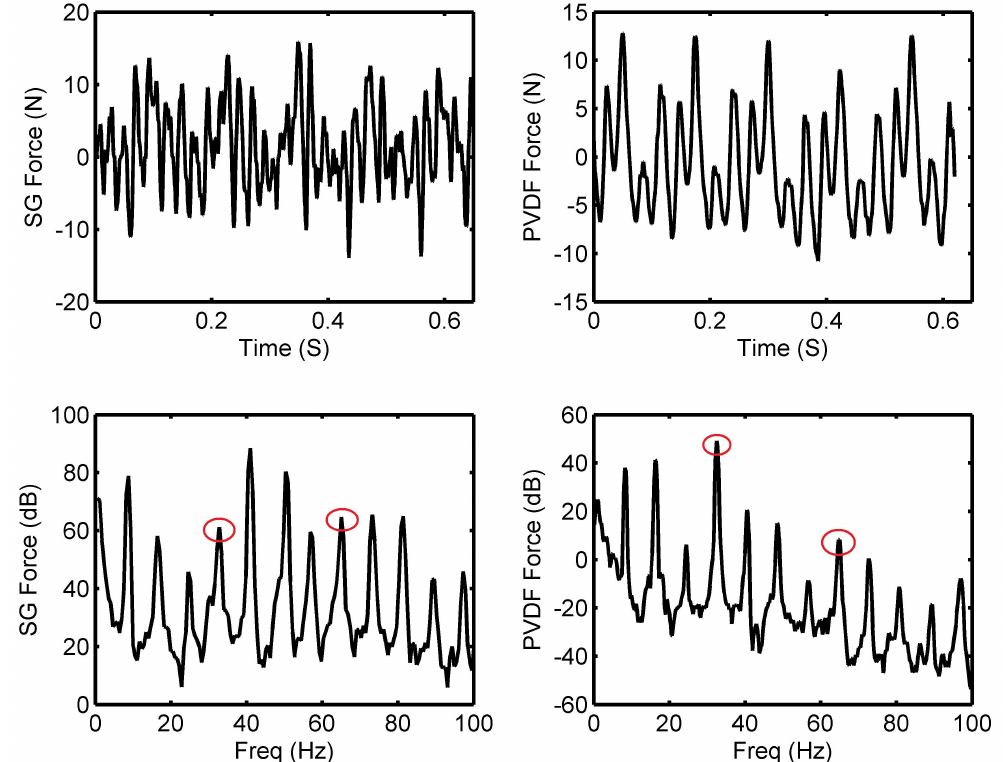
Figure 10. Comparison of the predicated force of the thrust bearing to the localised force measured by the PVDF film for the brass two-blade propeller, four Pad thrust bearings rotating at 500 RPM. Where (top) is the time domain and (bottom) is the frequency domain. The circles indicate the PPF and the modulation